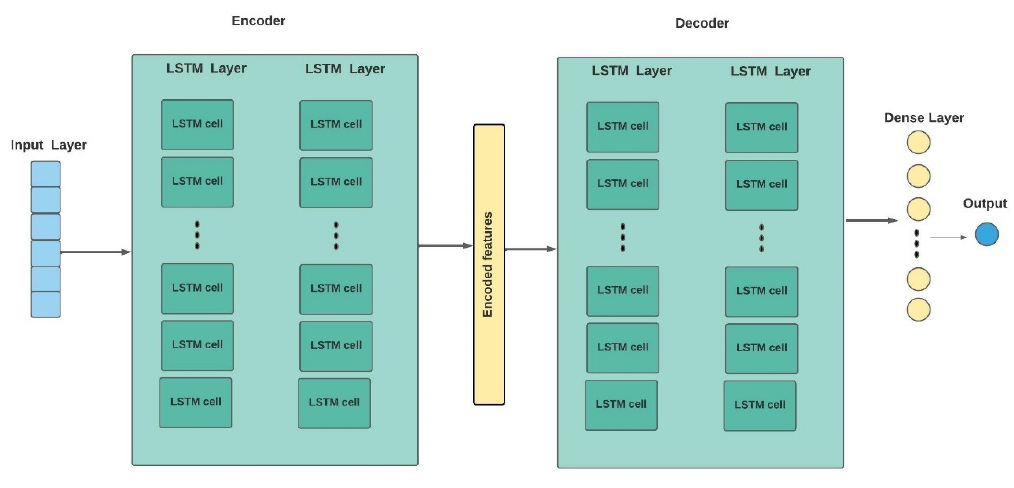
Figure 21. LSTM-AE forecasting model.